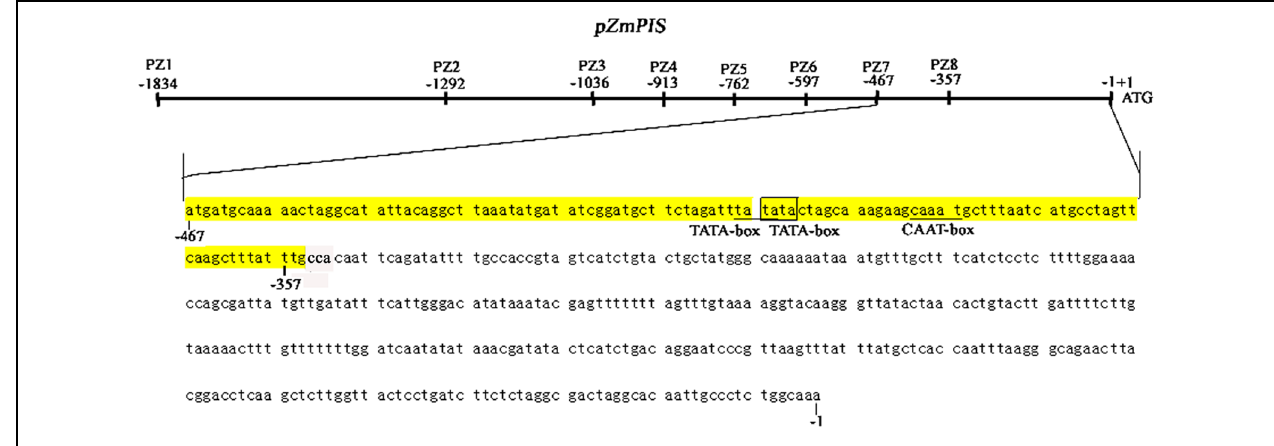
FIGURE 8 | The diagram of 467 bp ( − 467 to − 1 bp) core promoter segment (PZ7) and 113 bp ( − 467 to − 355 bp) key region for responding to salinity and osmotic stress of ZmPIS . Known cis -acting elements in the 113 bp region of pZmPIS using the PlantCARE and PLACE databases are shown in underline or border. TATA-box: core promoter element around − 30 of transcription start. CAAT-box: common cis -acting element in promoter and enhancer regions.